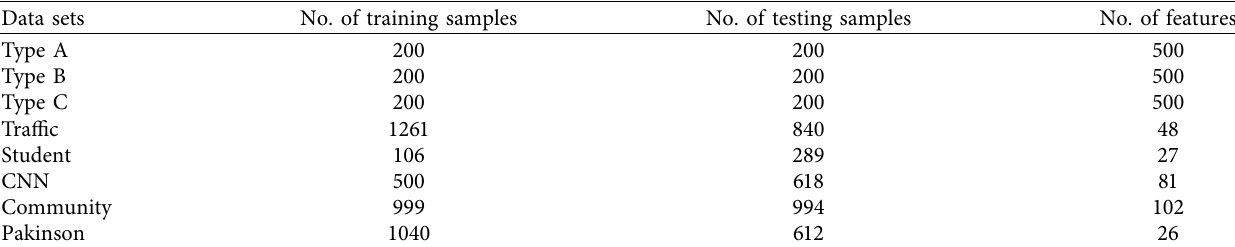
Table 1: Specifcation of datasets.